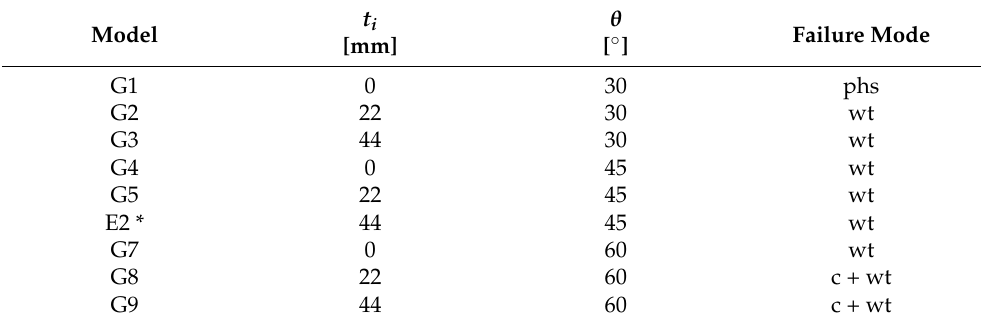
Table 4. Parametric analysis on screw inclination and interlayer thickness, with evidence of corre- sponding failure modes.